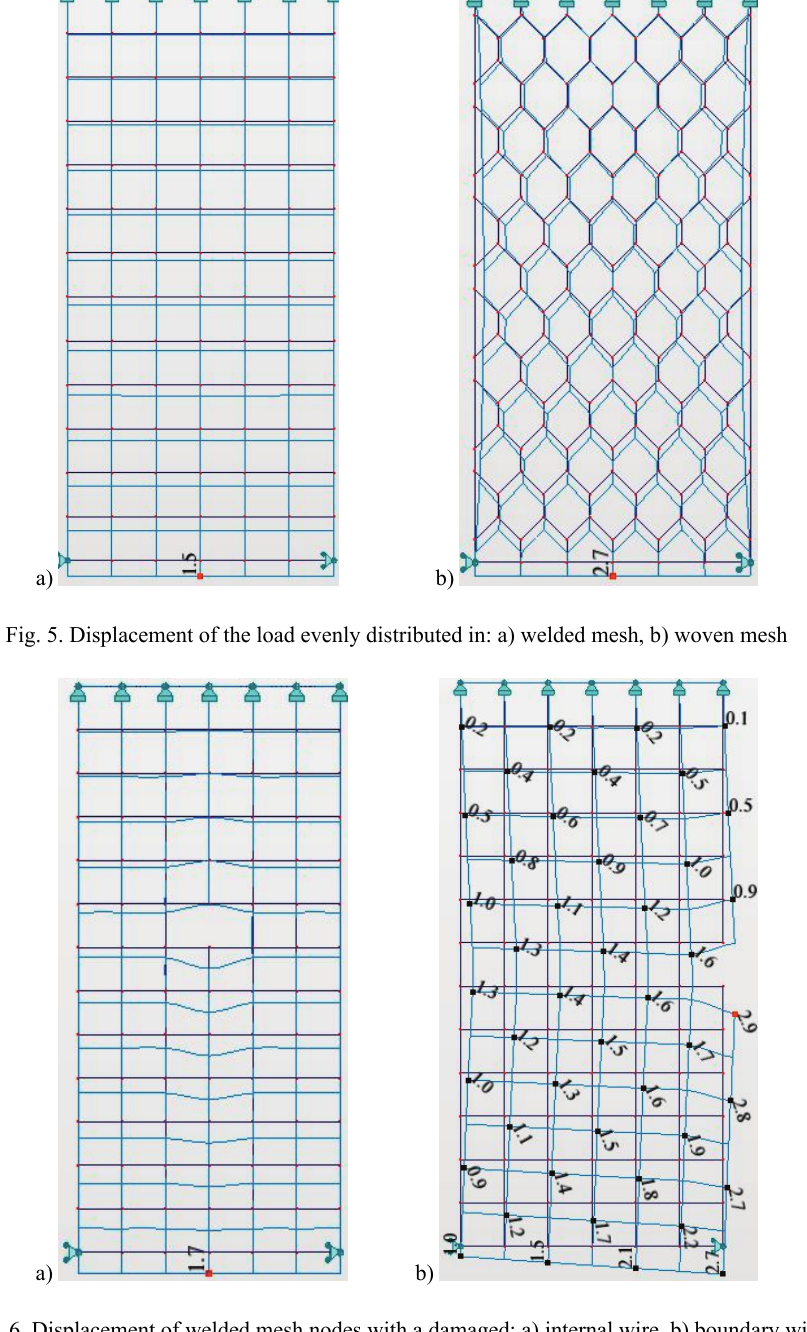
Fig. 6. Displacement of welded mesh nodes with a damaged: a) internal wire, b) boundary